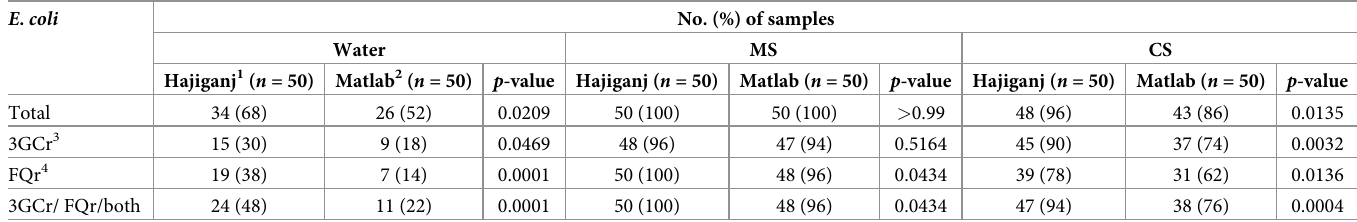
Table 1. Prevalence of total E . coli and antibiotic-resistant E . coli in water, mother stool (MS), and child stool (CS) in Hajiganj and Matlab. E . coli No. (%) of samples